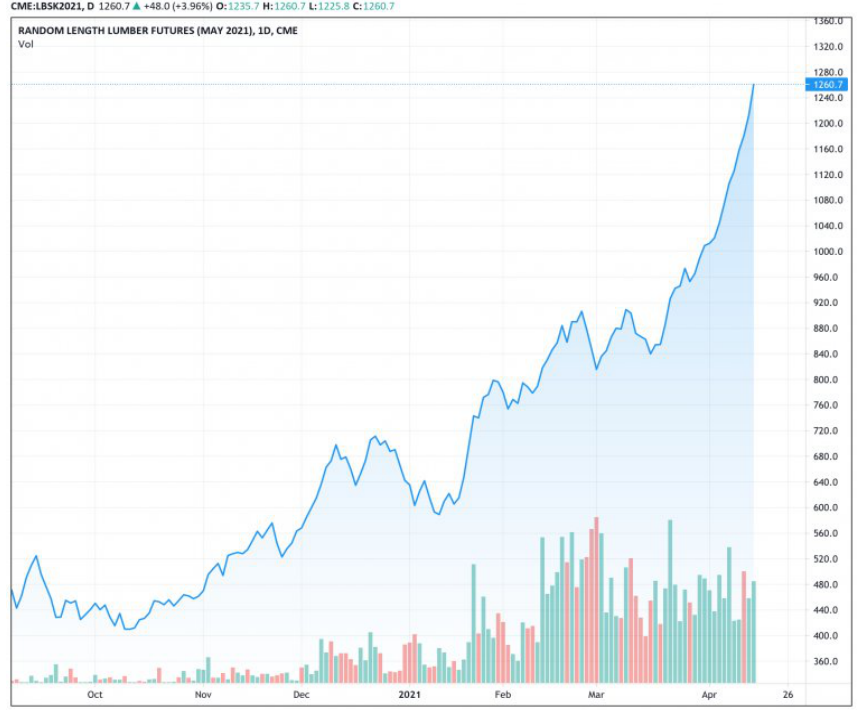
Figure 28. Increase in construction timber prices on the US contract market [USD/mbf], photo CME Group [82].